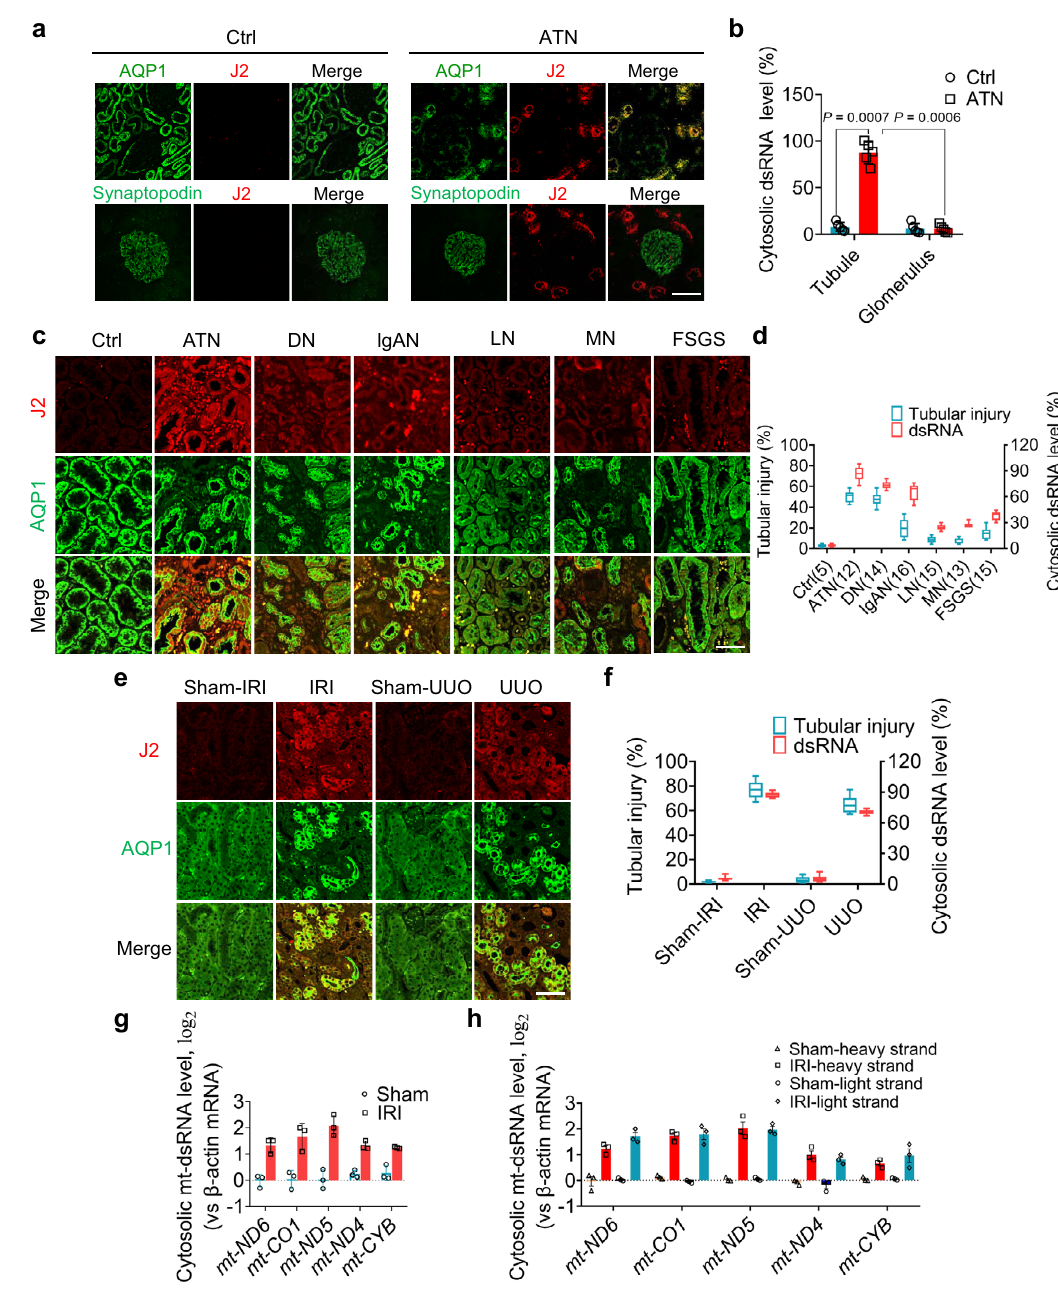
Fig. 1 | Detection of cytosolic mt-dsRNAs in injured renal tubular cells. a ImmunostainingofcytosolicdsRNAbyJ2antibodyintubuleandglomerulusfrom acute tubular necrosis (ATN) patients and controls. Tissue sections were stained withanti-aquaporin 1(AQP1)antibody(tubularcell)oranti-synaptopodinantibody (podocyte). b Quanti fi cation of cytosolic dsRNA levels in tubules and glomerulus (5 patients/group). c Immunostaining of dsRNA (J2) from 85 patients with various degrees of renal tubular injury, including ATN (5 males and 7 females), diabetic nephropathy (DN, 8 males and 6 females), IgA nephropathy (IgAN, 9 males and 7females),lupusnephritis(LN,5malesand10females),membranousnephropathy (MN,8malesand5females)andfocalsegmentalglomerulosclerosis(FSGS,6males and 9 females), as well as 5 non-renal tubular injury controls (3 males and 2 females). d Evaluation of tubular injury degree and cytosolic dsRNA